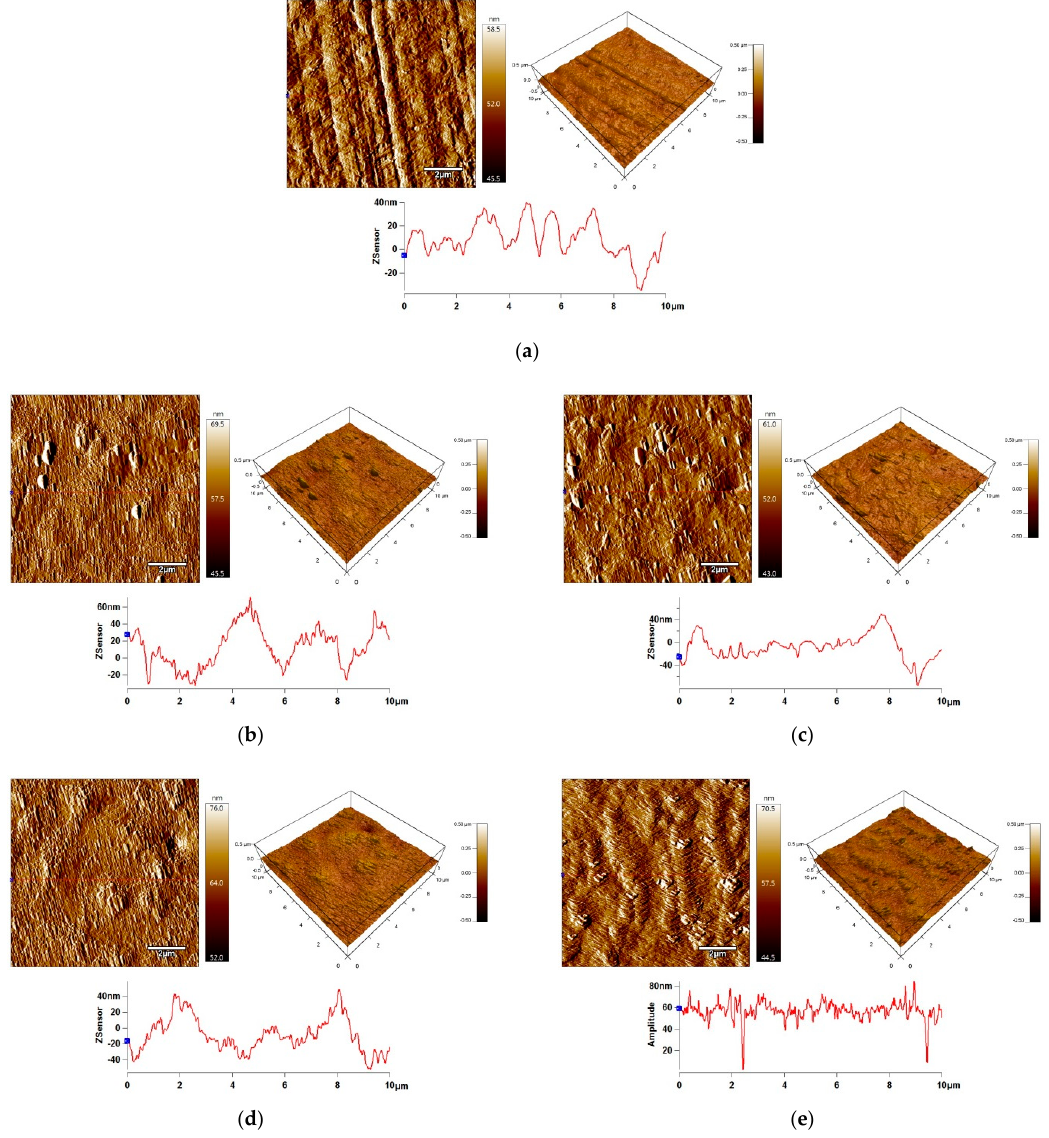
Figure 24. AFM height images of LDPE: ( a ) untreated ( R a = 15.7 nm); and plasma treated (120 s) in: